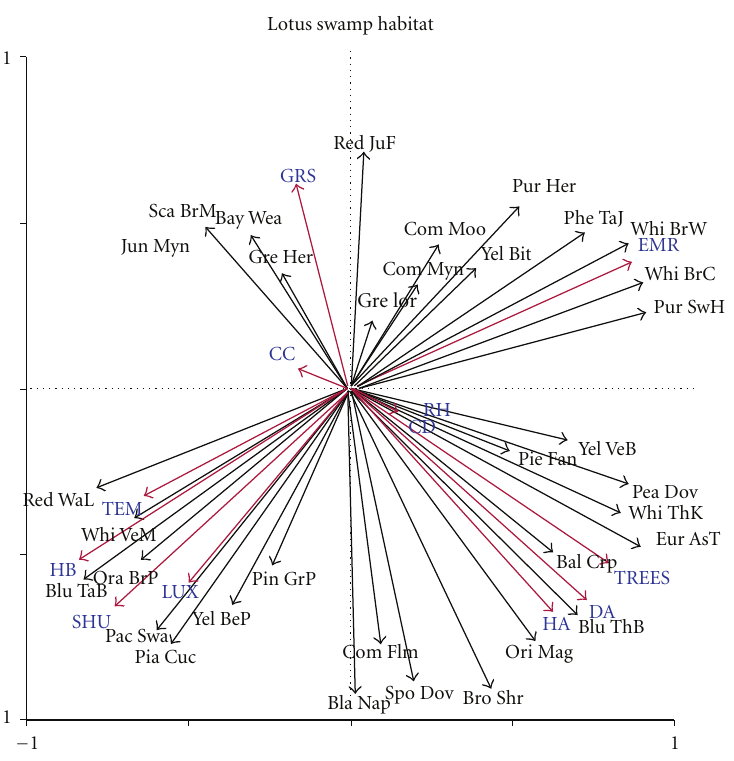
Figure 3: Ordination plot from a redundancy analysis of the distribution of birds of lotus swamp in relation to 14 environmental variables (for details see Table 2). The biplot of axes 1 and 2 is presented; the orientation of each variable in relation to each of these axes is presented by an arrow, the length of which indicates the degree of correlation with those